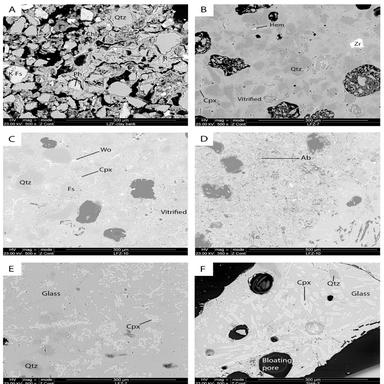
SEM photomicrographs of A) raw material with quartz (Qtz), alkaline feldspar (Afs) and chlorite minerals (Chl); R: rutile; Ph: Phengite B) ViS zone with quartz grai ns in well sintered/vitrified matrix and the beginning of mineral neoformation; Zir: detrital zircon; Hem: hematite grain C) ViS/NM zone with a vitrified matrix and wollastonite (Wo) and clinopyroxene (Cpx) minerals forming a reaction rim around quartz grains (Qtz); Fs: feldspar, D) elongated newly formed plagioclase (Ab: albite) crystals in a v